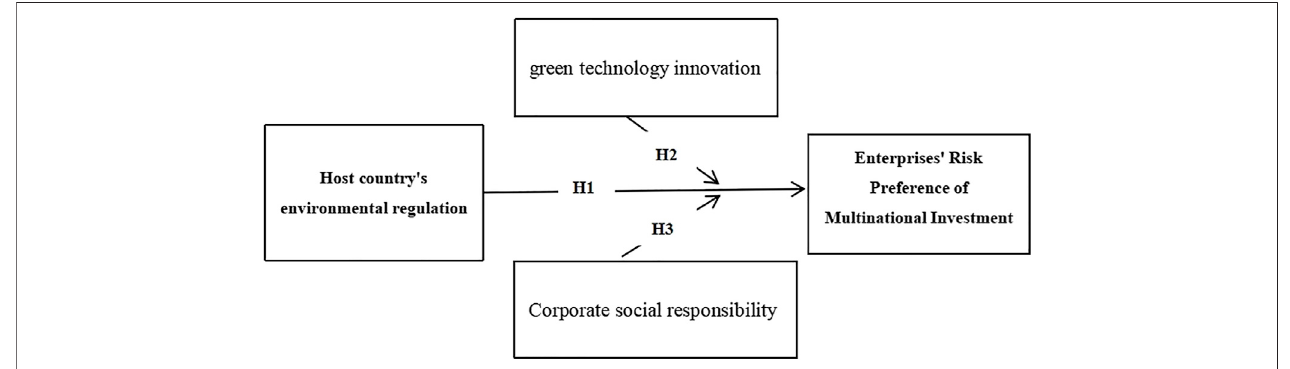
FIGURE 1 | Graphical representation of the research